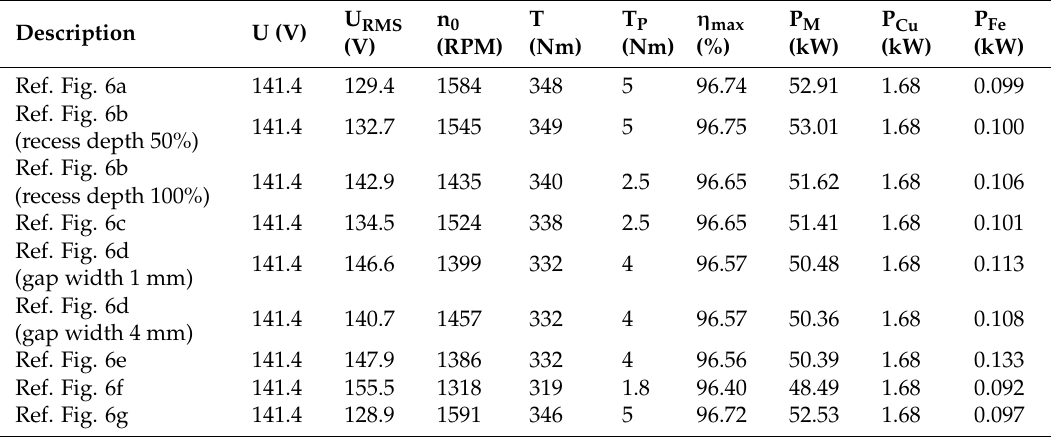
Table 7. Influence of the flat magnet attachment method on the obtained ERPMSM parameters.